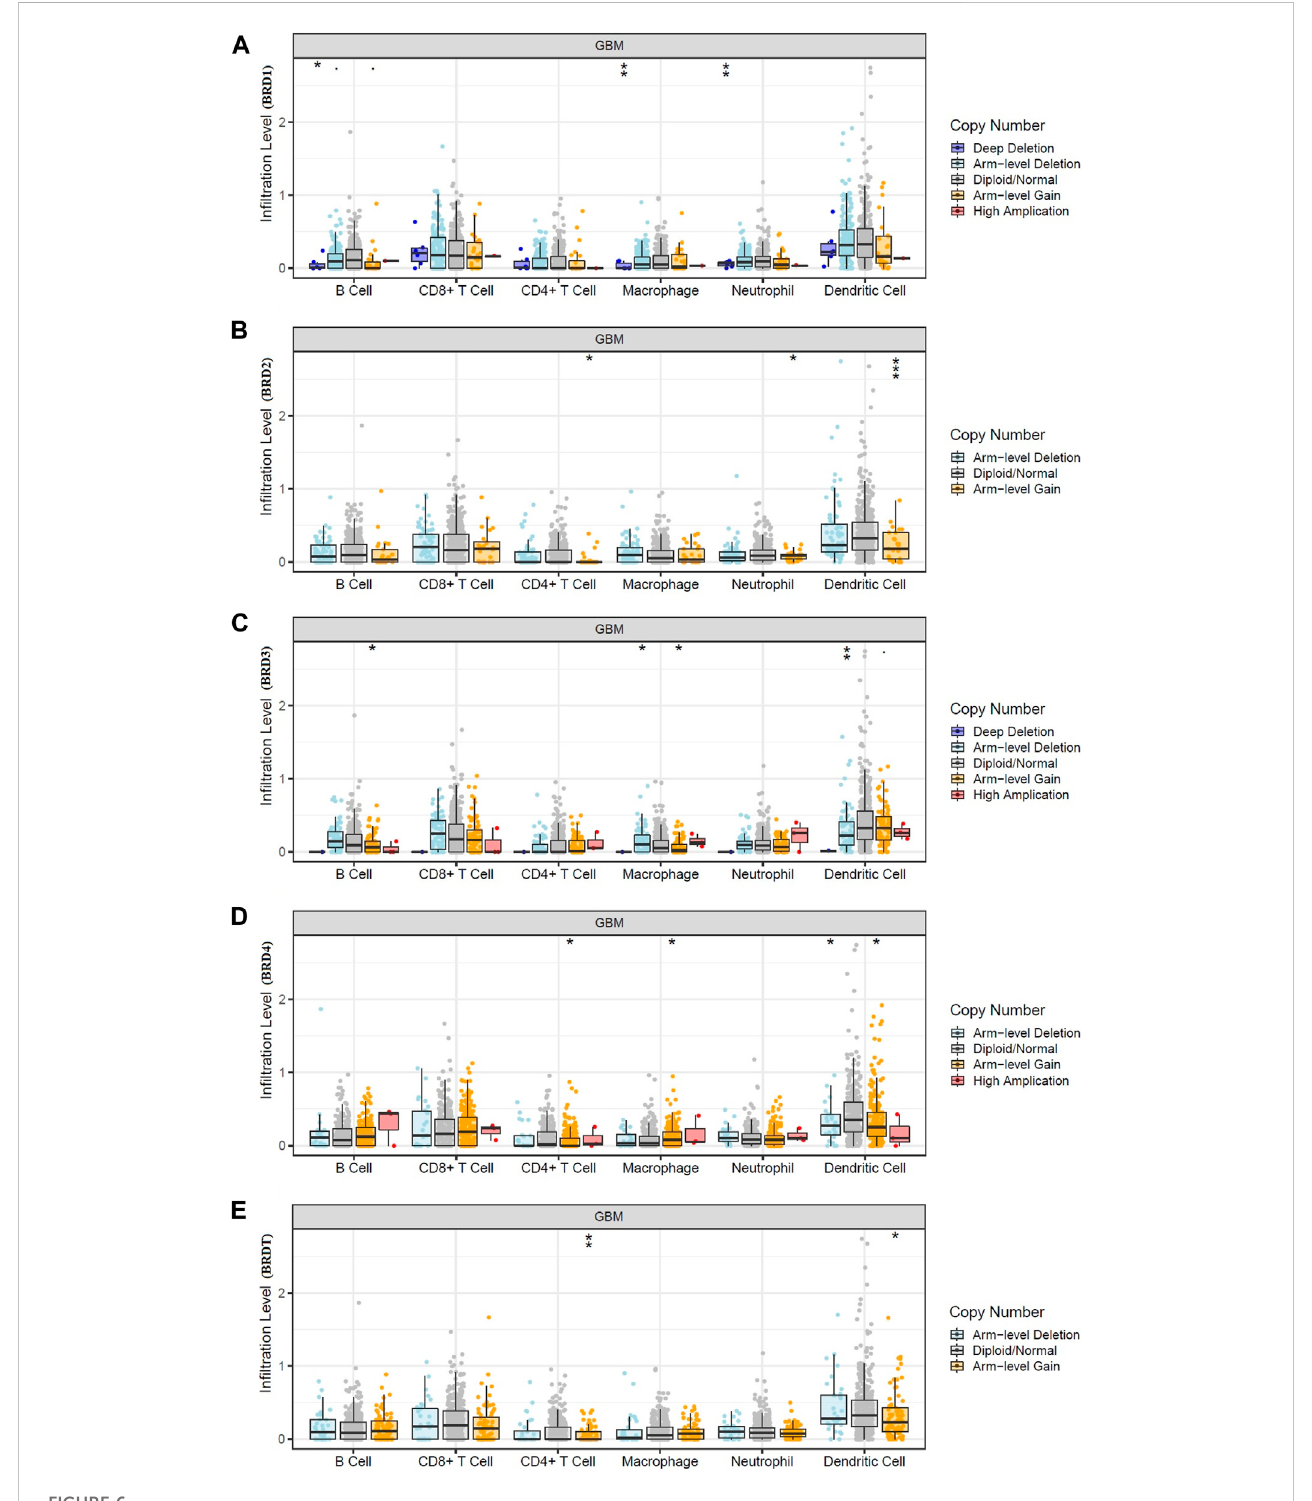
FIGURE 6 Effect of gene copy number changes expressed by differentBET genes expression on immunecell in fi ltration in TIMER database. (A) BRD1, (B) BRD2, (C) BRD3, (D) BRD4, (E) BRDT.